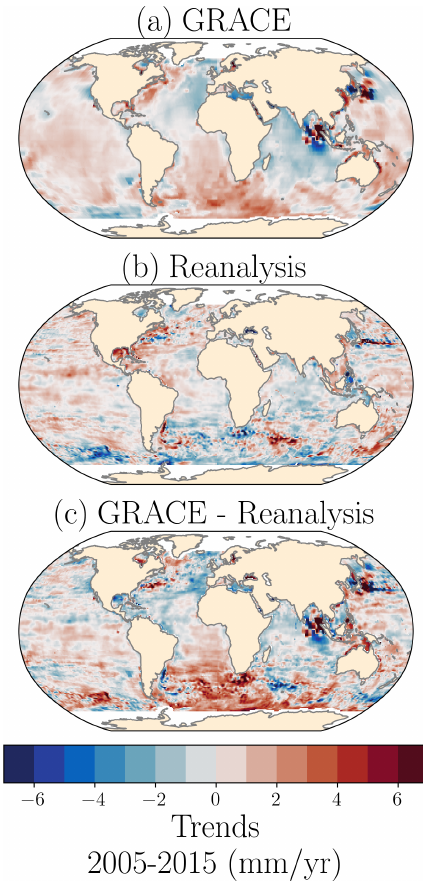
Figure A1. Dynamic sea-level change ( η DSL ) estimated from (a) GRACE (average of JPL and CSR mascons), (b) an ensemble of ocean reanalysis, and (c) the difference between GRACE and the reanalysis.